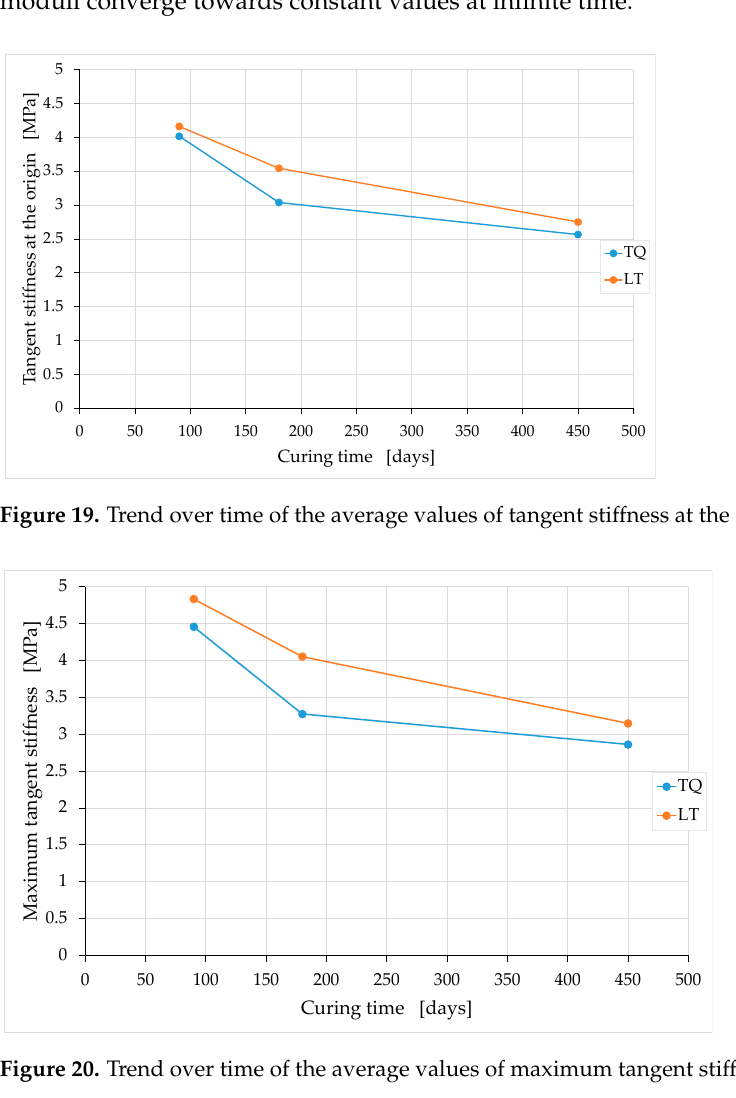
Figure 18. Trend over time of the average values of the ratios between maximum tangent stiffness and tangent stiffness at the origin: TQ and LT mixes.